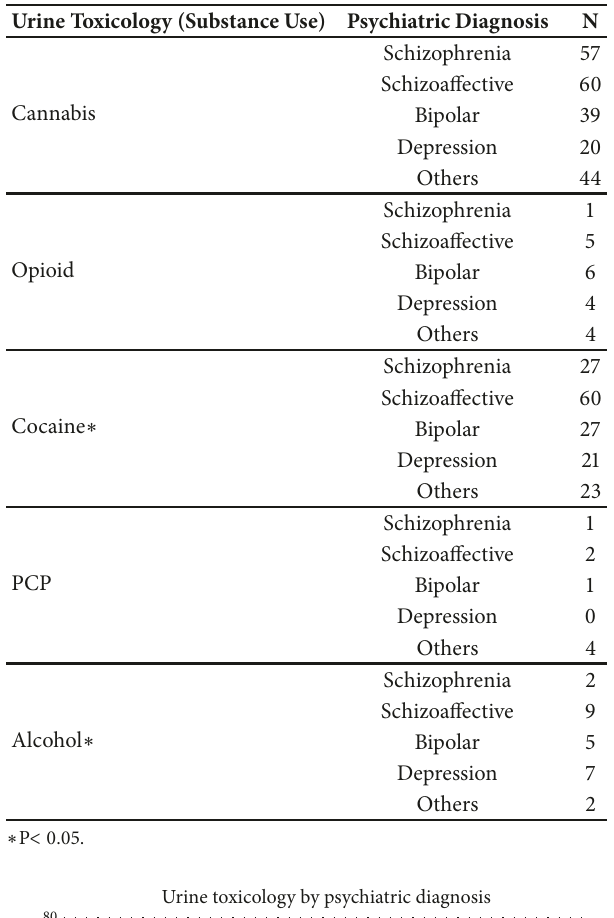
Table 2:Thedistribution of substancesby psychiatricdiagnosis (N= 431).